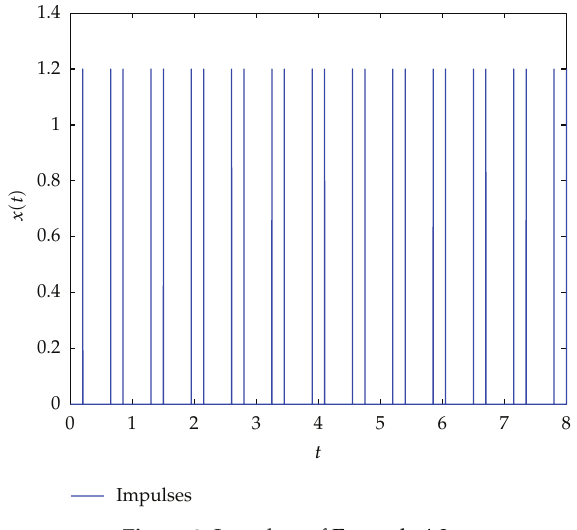
Figure 3: Impulses of Example 4.2.